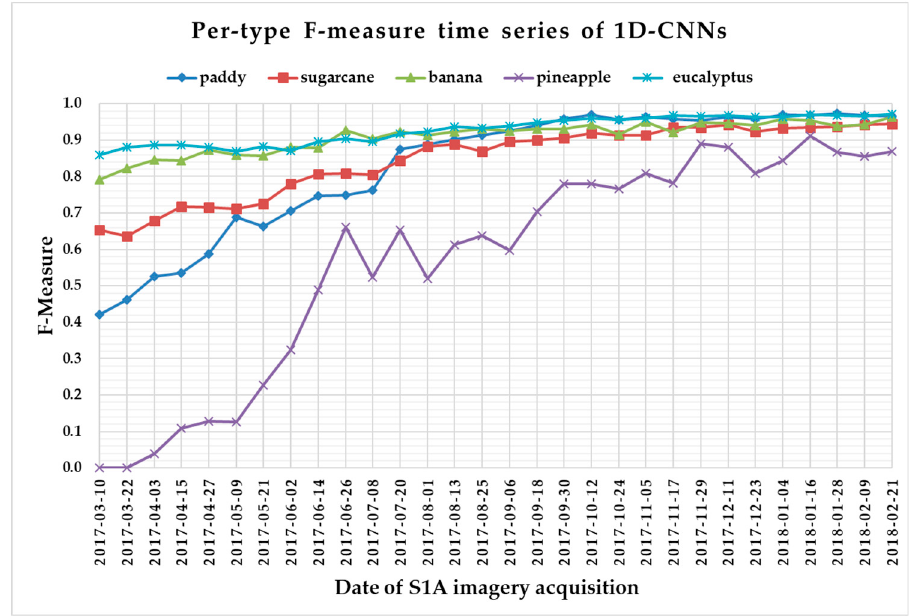
Figure 14. F-measure time series of long short-term memory recurrent neural networks.